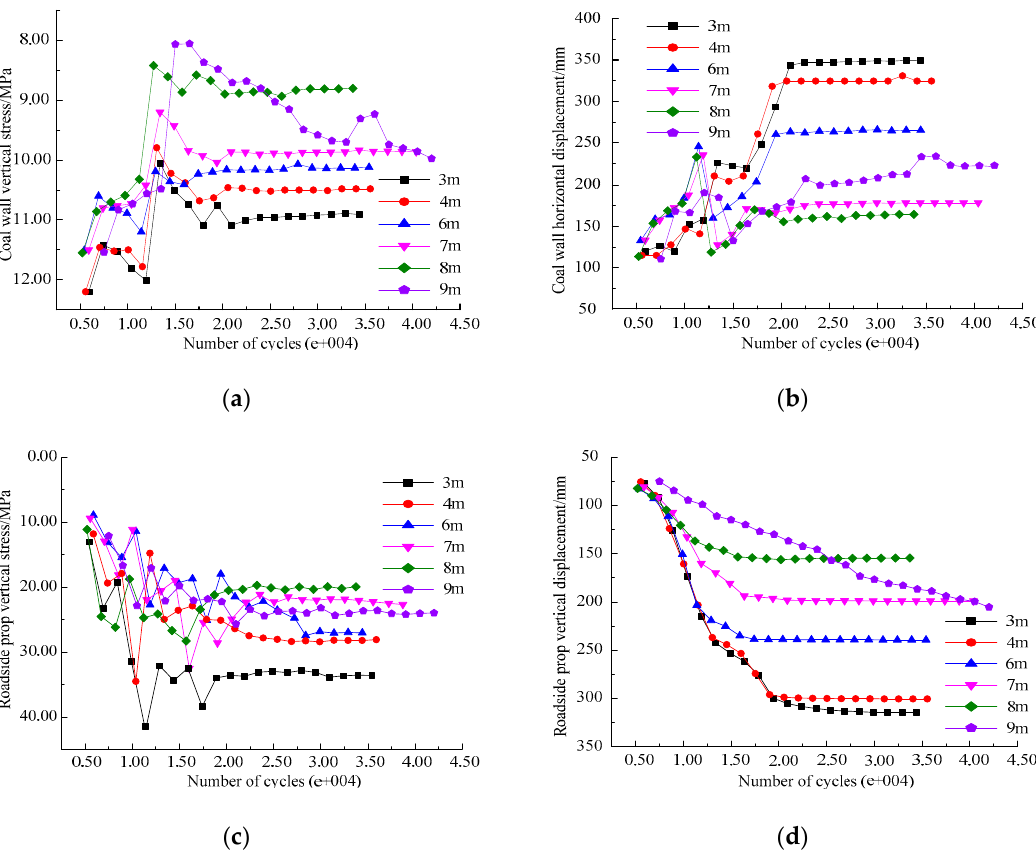
Figure 16. Monitoring points curves after excavation for different cutting heights. ( a ) Coal wall vertical stress; ( b ) Coal wall horizontal displacement; ( c ) Roadside prop vertical stress; ( d ) Roadside prop vertical displacement.